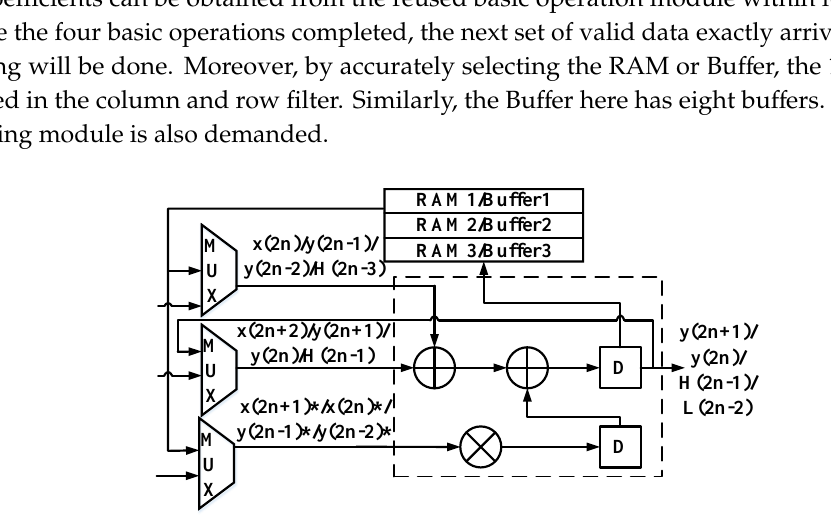
( c ) Figure 8. Structure of the transposing module and the orders of the input and output. ( a ) For the condition of 1:1 clock-to-data ratio. ( b ) For the condition of 2:1 clock-to-data ratio. ( c ) For the condition of 4:1 clock-to-data ratio. It should be noticed that, the proposed architecture can integrate each 3-level DWT system into a clock domain, so it can extend to higher levels, by dividing the entire multilevel DWT system into multiple 3-level DWT systems. For example, in practical applications, such as JPEG2000 image